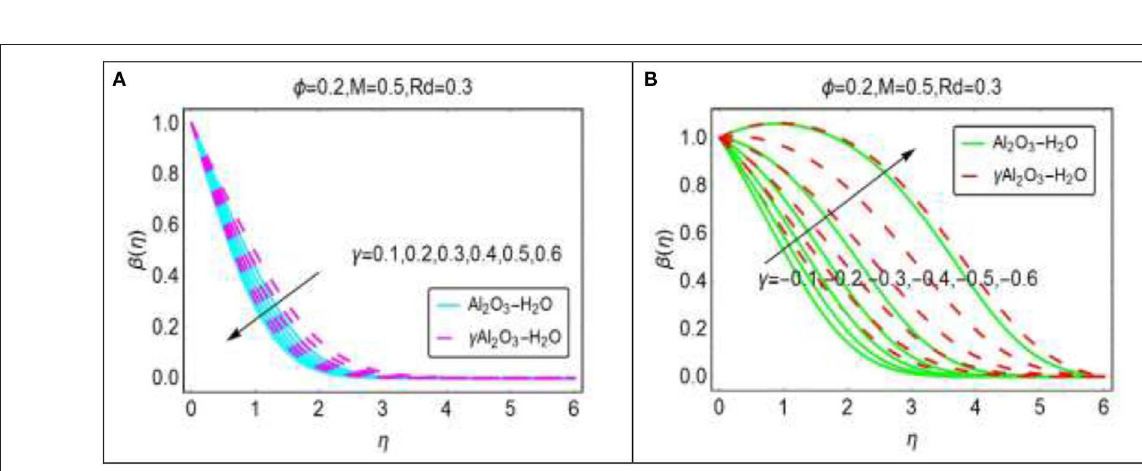
FIGURE 5 | The effects of M on dimensionless velocity F ′ ( η ) for (A) γ = 0.3, (B) γ = − 0.3.